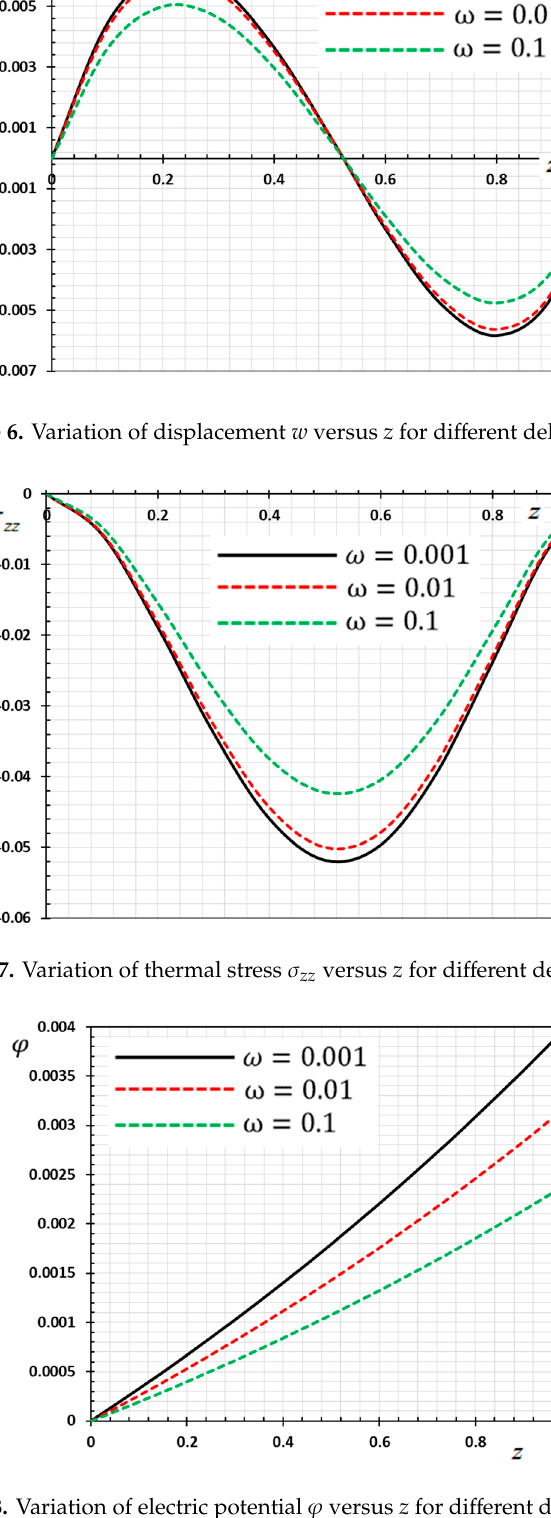
Figure 8. Variation of electric potential 𝜑 versus 𝑧 for different delay time 𝜔 .